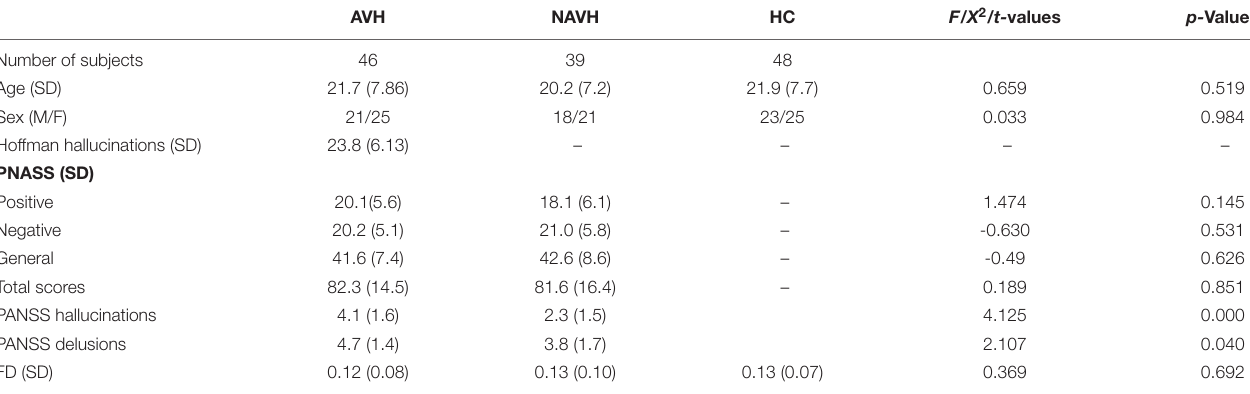
TABLE 1 | Demographic and clinical data of AVH patients, NAVH patients, and HC. AVH NAVH